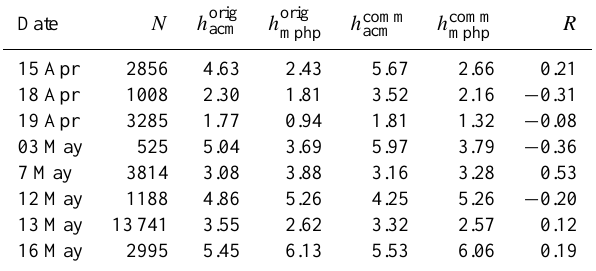
Table 3. Number of the common pixels ( N ) for the MPHP and ACM data, the corresponding average heights for the full original plumes (orig) and for common pixels only (comm), and the corre- lation coefficient R . Only the SPH values for ACM are shown